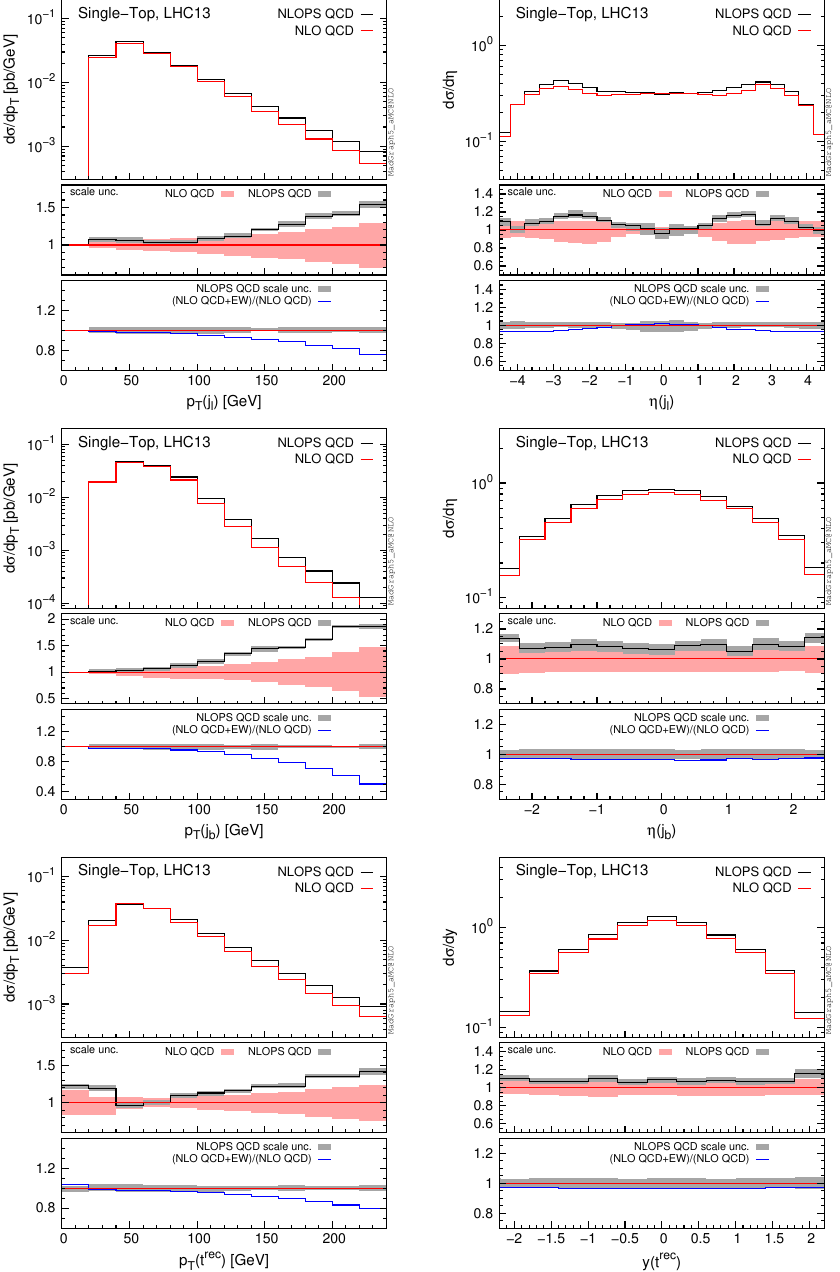
Figure 9 . Predictions at NLO(PS) QCD accuracy for the same observables considered in (cid:12)gure 2 for the Single-Top process. Note that the second inset shows the ratio of the NLO QCD+EW over the NLO QCD process, but with the relative uncertainty from the NLOPS QCD superimposed on the latter.